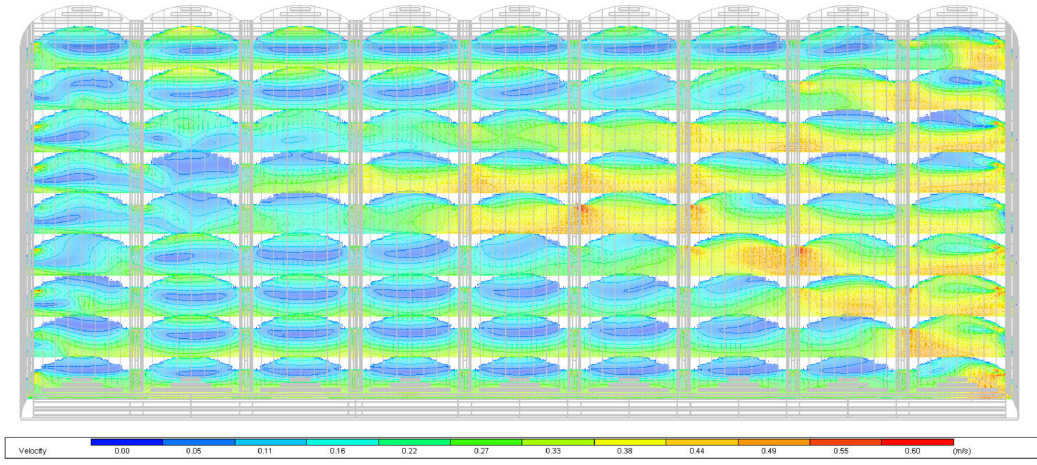
Figure 19. Wind speed cloud map of the crossed multi-arch greenhouse (outdoor wind speed 1